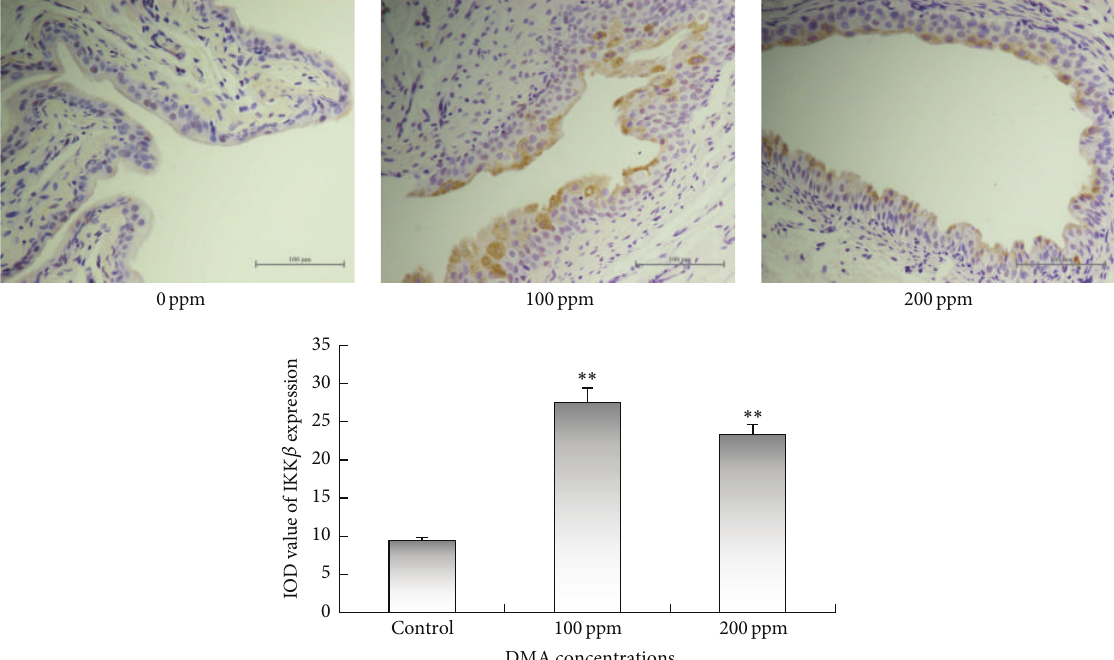
Figure 4: IKK 𝛽 immunohistochemical staining of bladder epithelium in DMA V treated rats. IKK 𝛽 expressions were presented in brown in cytoplasm. The panel was a graphical representation of the immunointensities of IKK 𝛽 . Bars were presented as mean ± SD. ∗∗ 𝑝 < 0.01 compared to the control group.